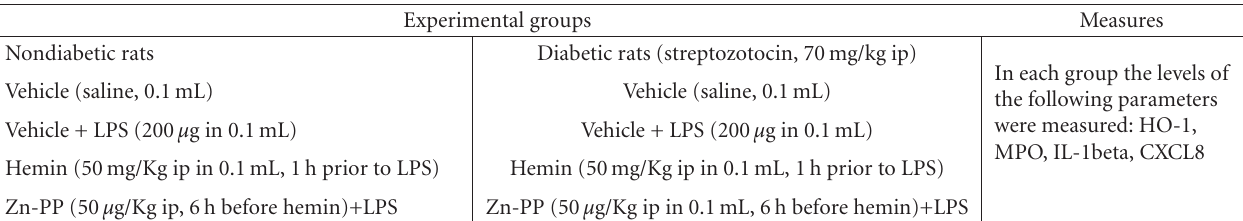
Table 1: Schematic representation of the experimental groups and measures done for each group. Experimental groups Measures